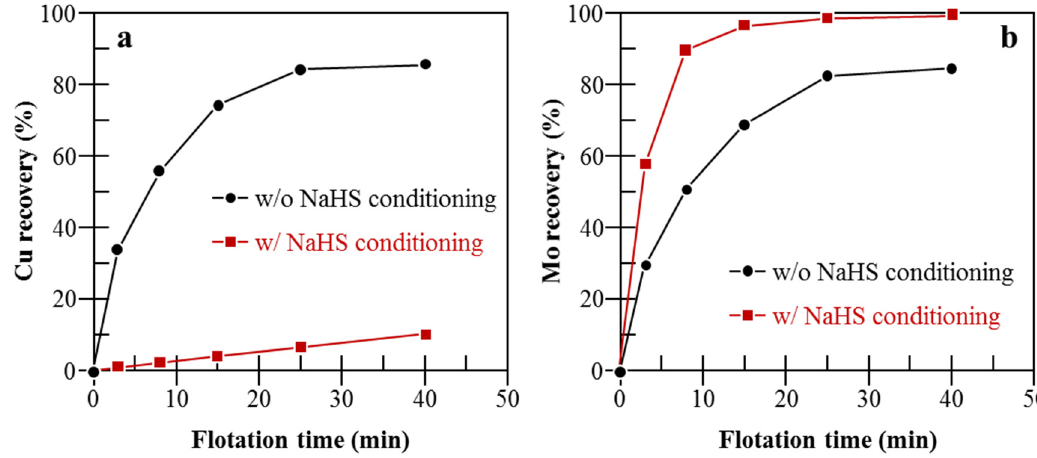
Figure 3. Effects of NaHS on recovery of ( a ) chalcopyrite and ( b ) molybdenite (reprinted with permission from Hirajima et al. [13], copyright (2017) Elsevier).